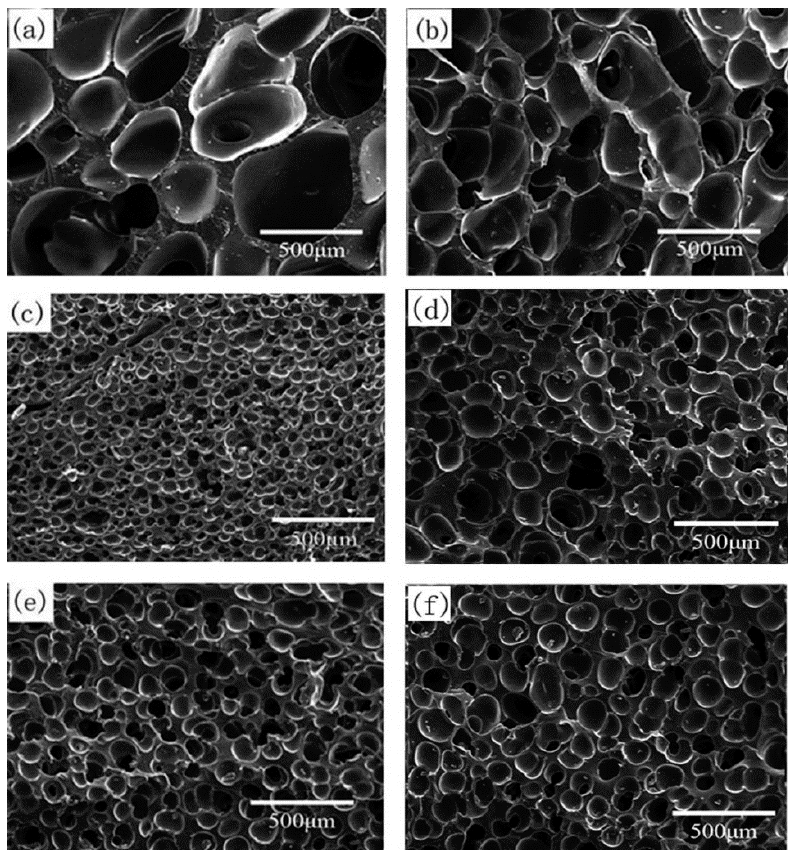
Figure 11. Cell morphology of foamed samples with different foaming times: ( a ) 20 min; ( b ) 40 min; ( c ) 60 min; ( d ) 80 min; ( e ) 100 min; ( f ) 120 min. Table 6. Parameters of foamed samples with different foaming times.